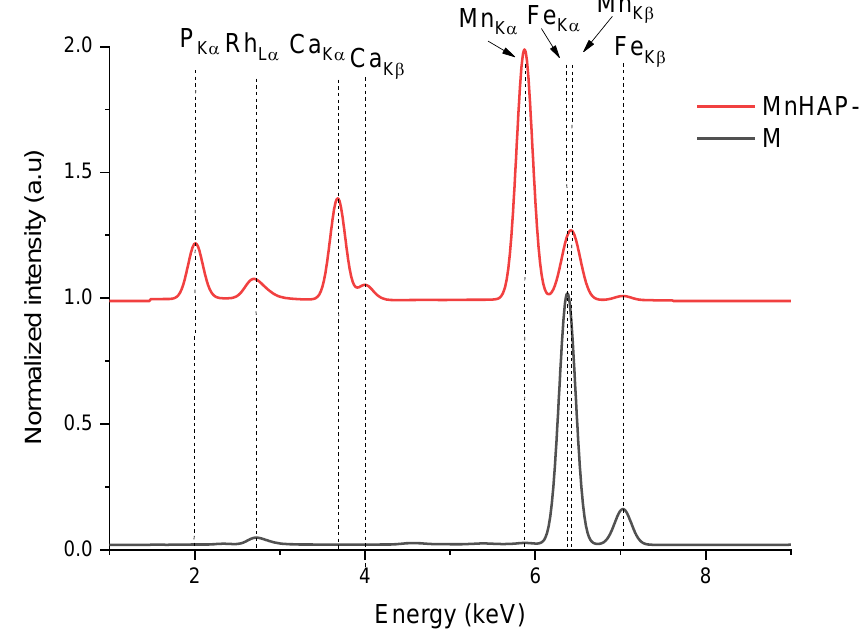
Figure 1. X-ray fluorescence (XRF) spectra of the obtained composite material (MnHAP-M) and of the magnetic iron oxide. Table 2. Elemental analysis of the MnHAP and MnHAP-M samples. L.E. — light elements (not detectable by XRF).